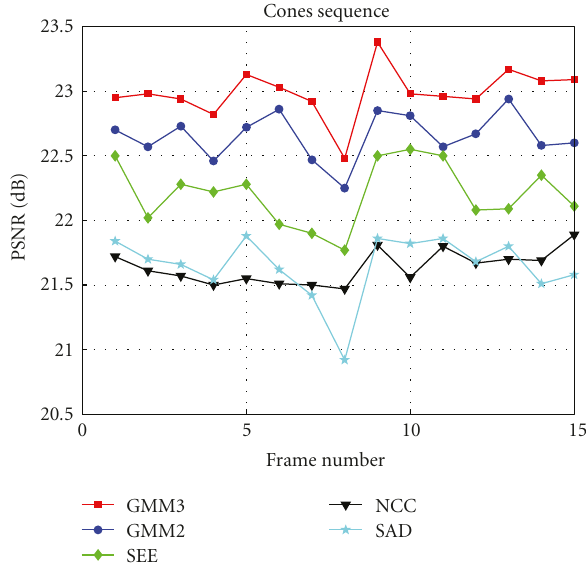
Figure 5: PSNR comparisons of GMM3, GMM2, SAD, SSE, and NCC algorithms for the “Cones” sequence without influence of